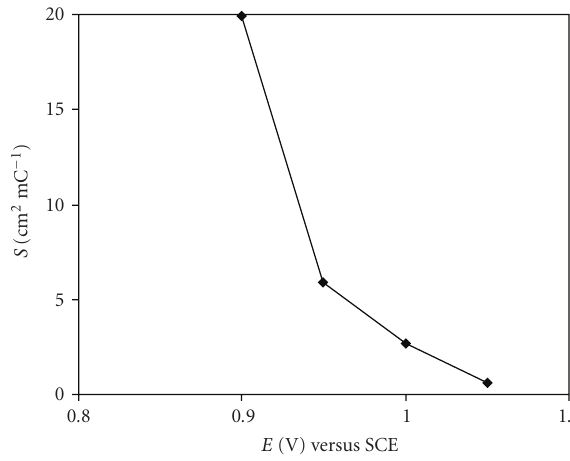
Figure 7: Potential dependences of the capture cross section per positive defect. This parameter is acquired from